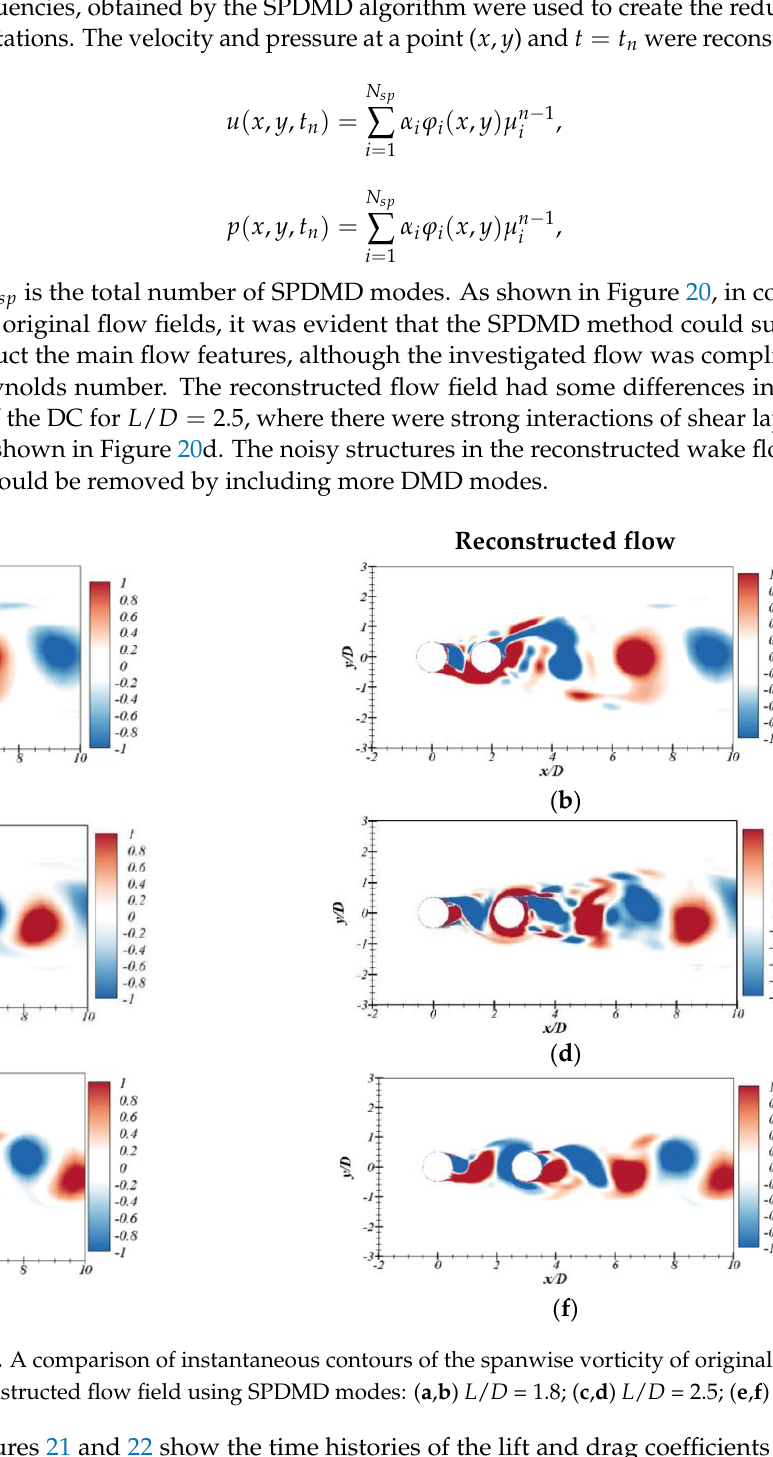
( f ) Figure 21. Time histories of ( a – c ) the UC lift coefficient and ( d – f ) drag coefficient obtained by the simulation results and reconstructed by using the selected DMD modes for 𝐿/𝐷 = 1.8, 2.5 and 3 : ( a , d ) 𝐿/𝐷 = 1.8 ; ( b , e ) 𝐿/𝐷 = 2.5 ; ( c , f ) 𝐿/𝐷 = 3 .